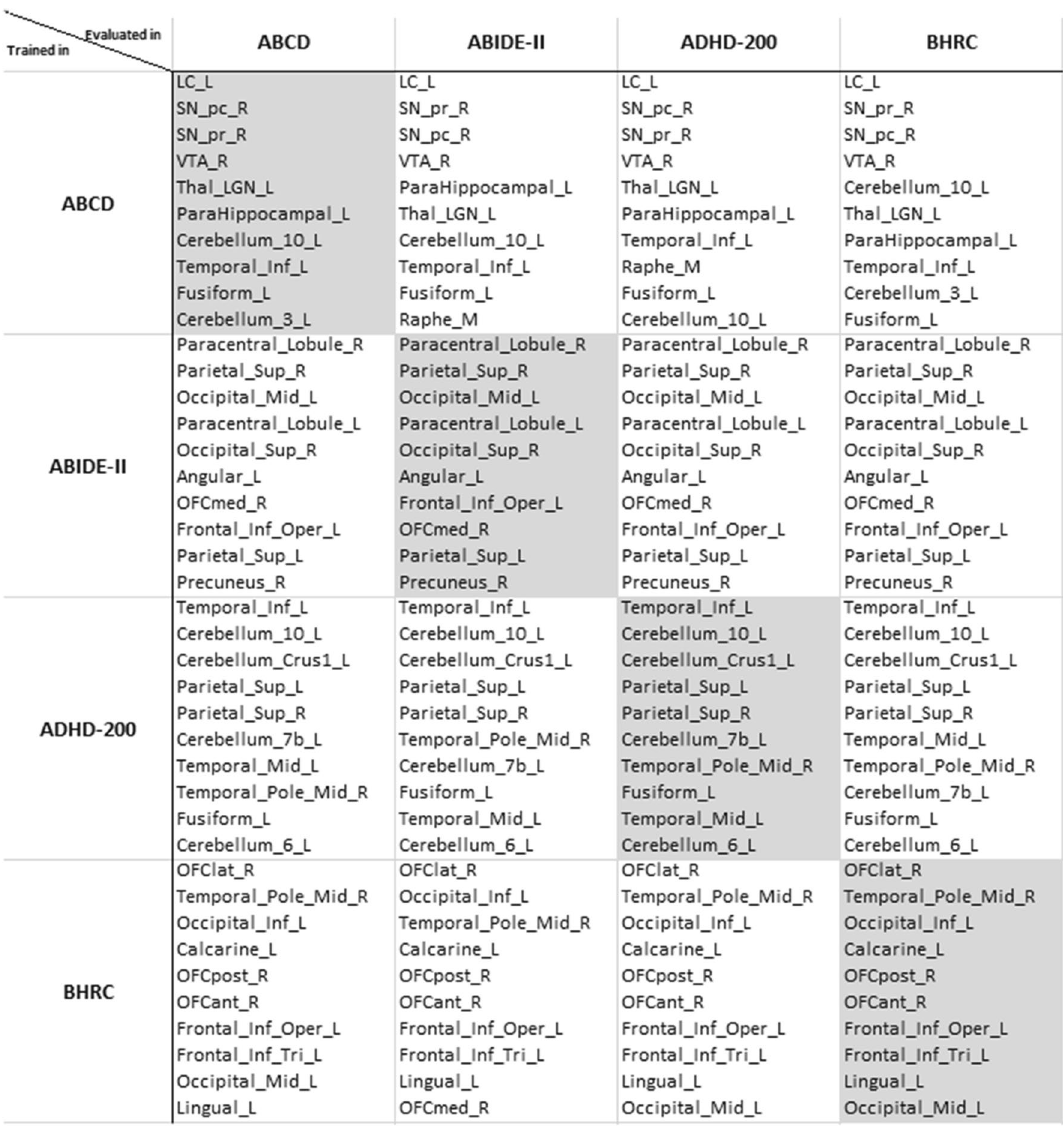
Figure 4. Top 10 most representative ROIs for different datasets in age prediction. The lists are ordered by the most to the less representative ROI. Notice that the set of ROIs from a given trained model is invariant to different datasets, and there is little or no difference in the ROIs’ importance for the evaluated datasets. The chosen trained models are the ones with the best performance in